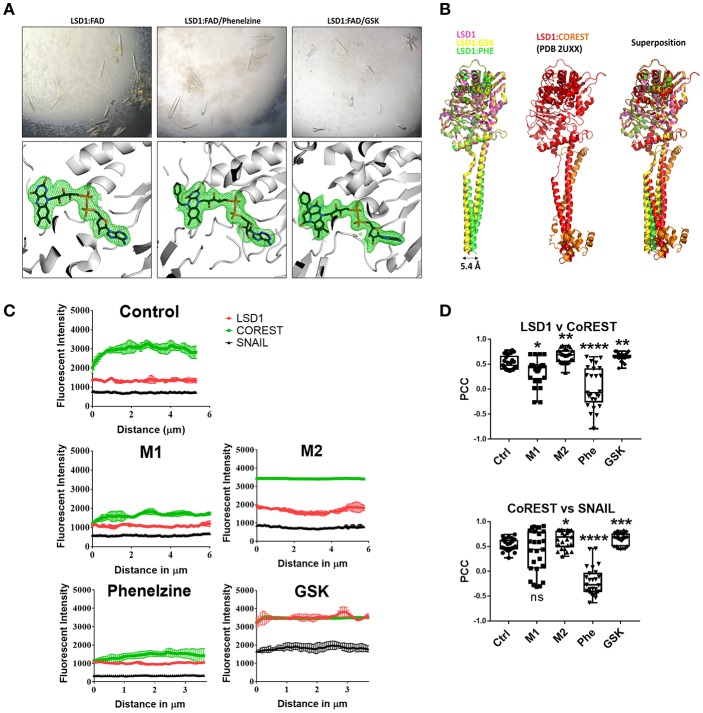
Phenelzine targets the FAD domain of LSD1 and potentially disrupts the LSD1/CoREST axis resulting in destabilization of LSD1 and its nuclear activity. (A) LSD1 protein crystals (top panel) grown in the absence (left) and presence of phenelzine (middle) and GSK2879552 (right). In the absence of inhibitors, strong density (bottom panels) was observed consistent with the FAD cofactor (shown as sticks colored with carbons black, nitrogen blue, oxygen red, and phosphate orange). The map is a simulated annealed omit map for FAD contoured at 2.5 sigma. LSD1 is colored gray and shown in cartoon mode. The FAD modifications by phenelzine (middle) and GSK (right) are supported by strong density, with corresponding maps and colors as per LSD1:FAD. (B) Structural superposition of LSD1 in the absence and presence of phenelzine and GSK. The structures solved in this study (left panel), LSD1 alone (pink) (PDB 6NQM), LSD1:GSK (yellow) (PDB 6NQU), and LSD1:phenelzine (green) (PDB 6NR5) are represented in cartoon mode. These structures are superimposed in the left panel, showing a high degree of structural homology in the LSD1 catalytic domain for all three structures. LSD1 alone and LSD1:GSK also show high structural conservation in the alpha-helical tails; however, LSD1:phenelzine has a 5.4 Å displacement in this region. This region is important for CoREST binding, as shown in the middle panel (PDB 2UXX). Superposition of all structures in the left and middle panels is shown on the right, highlighting that CoREST binding is mediated by the correct position of these domains. All images were generated in Pymol. (C) The plot-profile feature of ImageJ was used to plot the fluorescence signal intensity along a single line spanning the nucleus (n = 5 lines per nucleus, 5 individual cells) using the average fluorescent signal intensity for the indicated pair of antibodies plotted for each point on the line with SE. (D) Pearson's correlation coefficient (PCC) indicating the colocalization of LSD1/CoREST and CoREST/SNAIL. *p < 0.05, **p< 0.005, ***p < 0.0005, ****p < 0.0001 Mann–Whitney t-test.